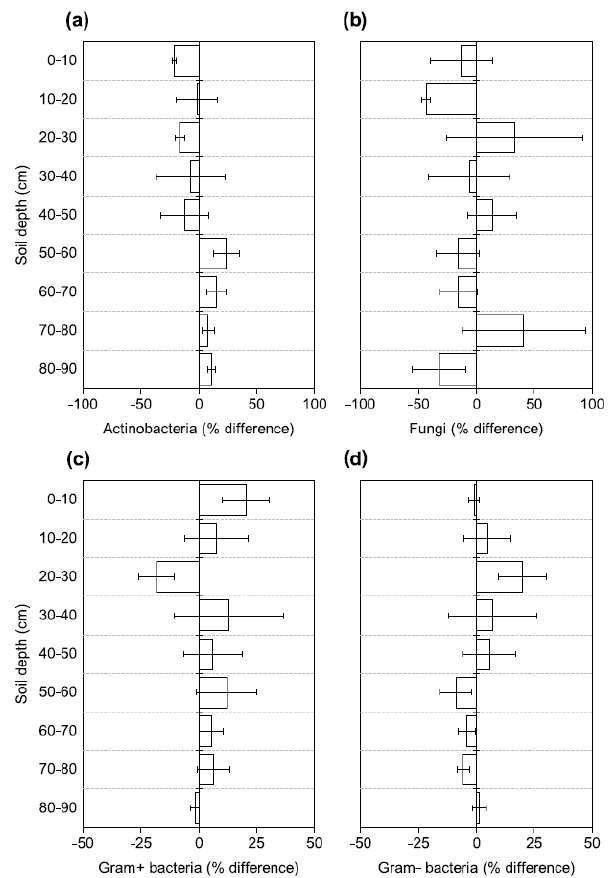
Figure 4. Changes in the relative abundance of (a) Actinobacteria, (b) fungi, (c) Gram + bacteria, and (d) Gram − bacteria based on PLFA biomarkers after 4.5 years of + 4 ◦ C soil warming. Values are shown as [(warmed–control)/control × 100] (mean ± SE; n = 3).